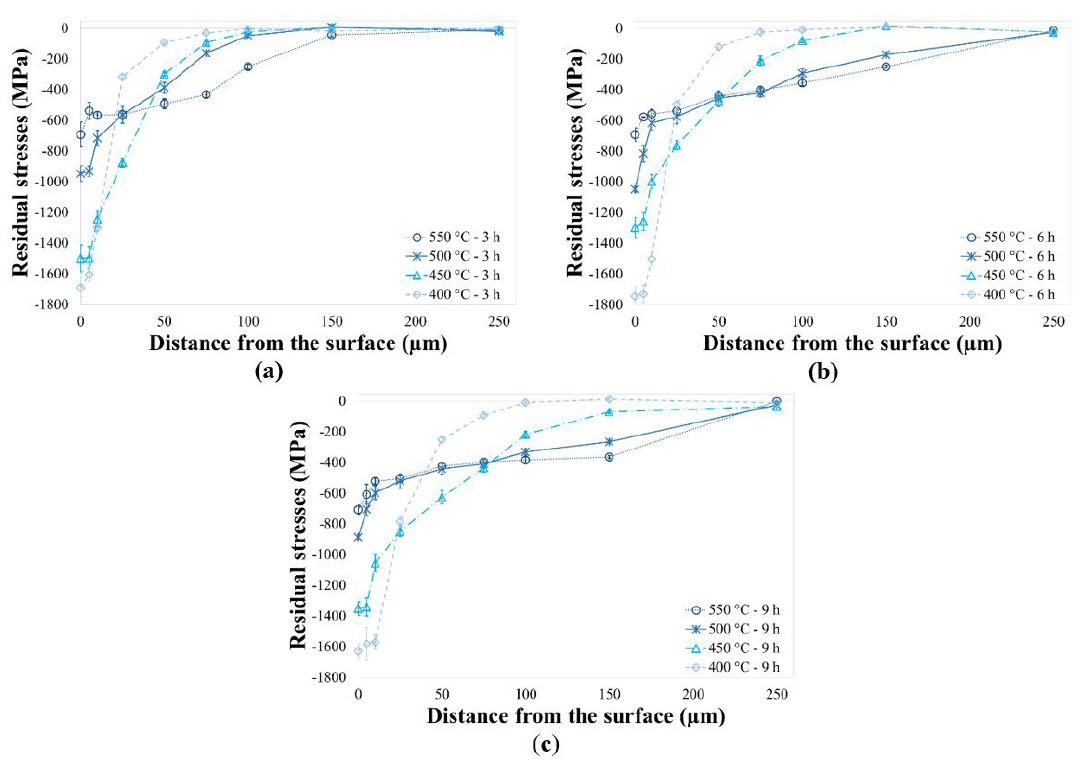
Fig. 6. Residual stress depth profiles for plasma nitrided samples for (a) 3 h, (b) 6 h and (c) 9